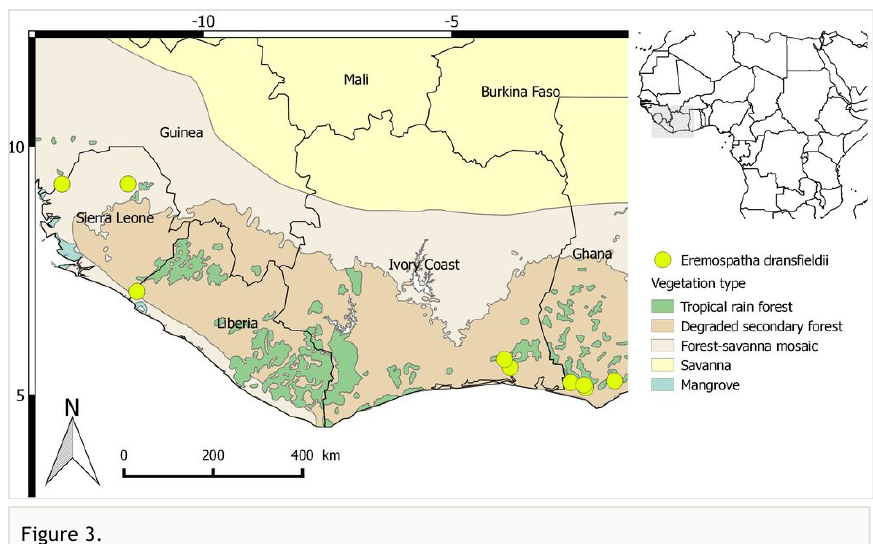
Figure 3. Distribution map of Eremospatha drans fi eldii